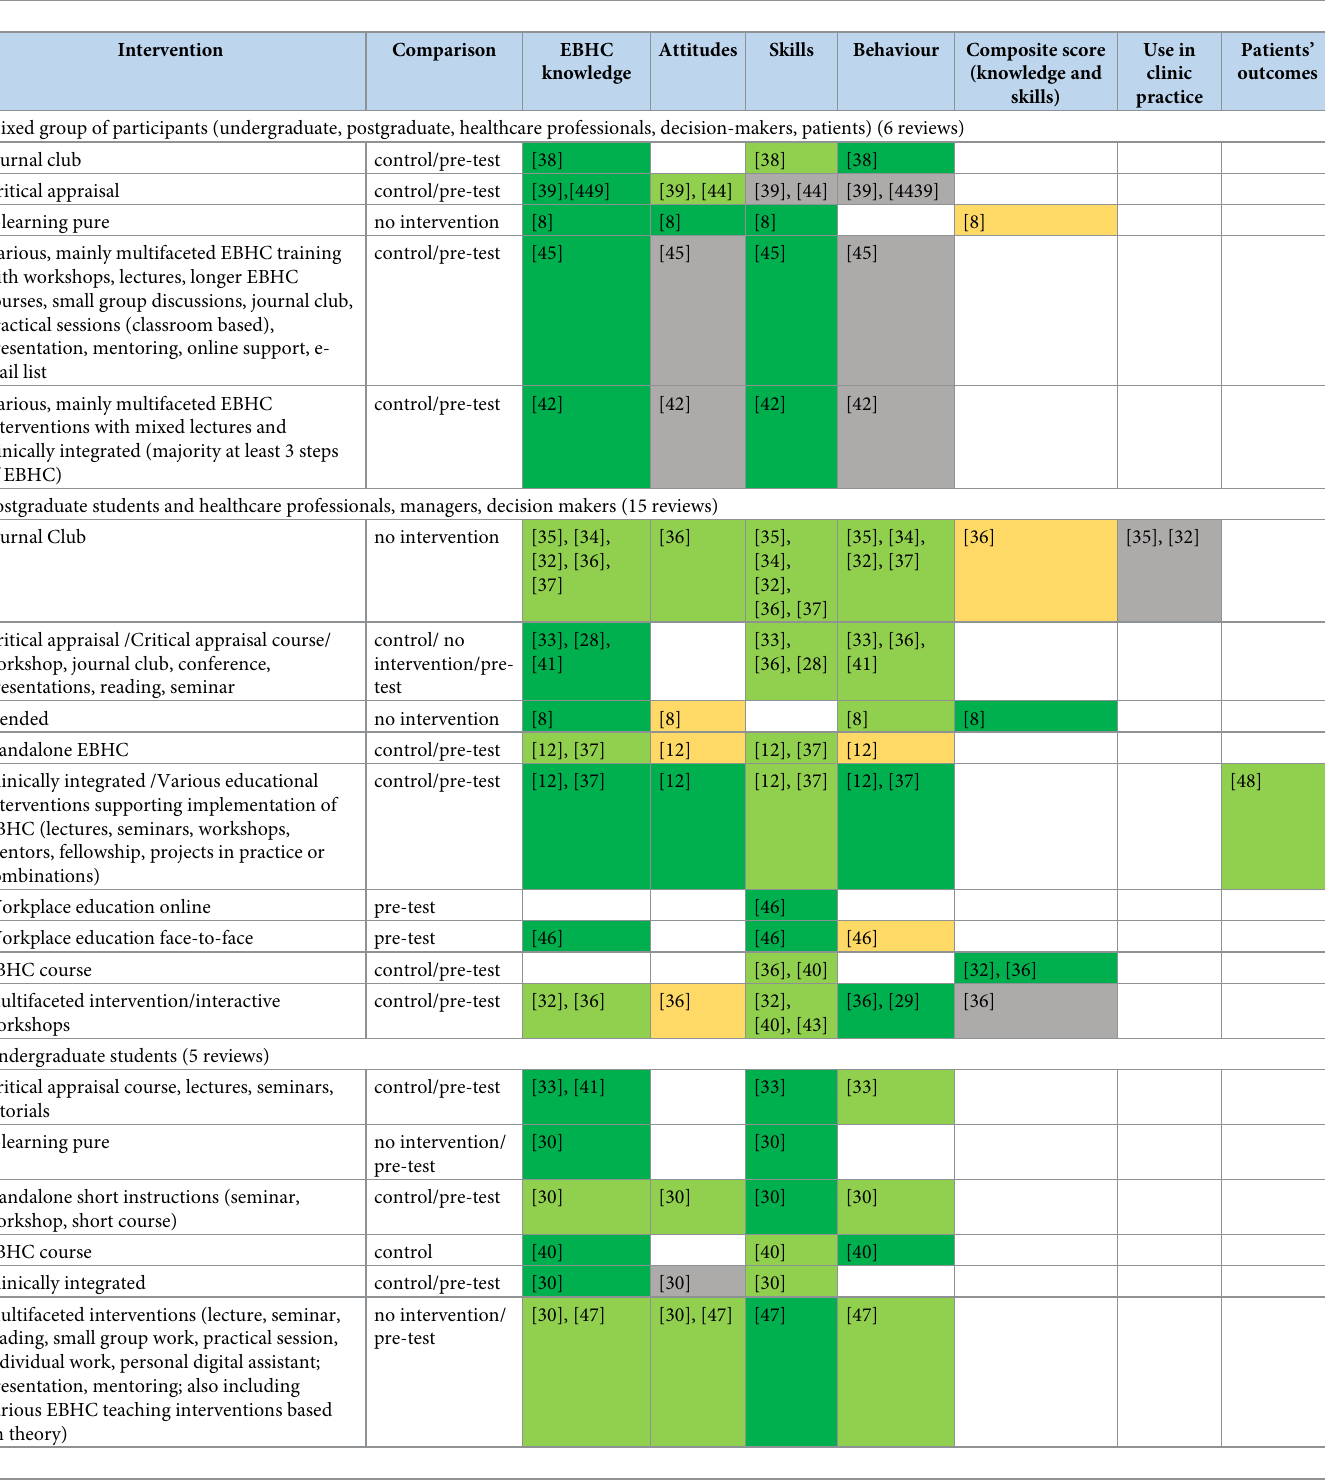
Table 3. A. Review level findings: Intervention vs no intervention (22 reviews–some of the reviews are shown in more than one population if separate data were pro- vided). B. Review level findings: Intervention vs other intervention (5